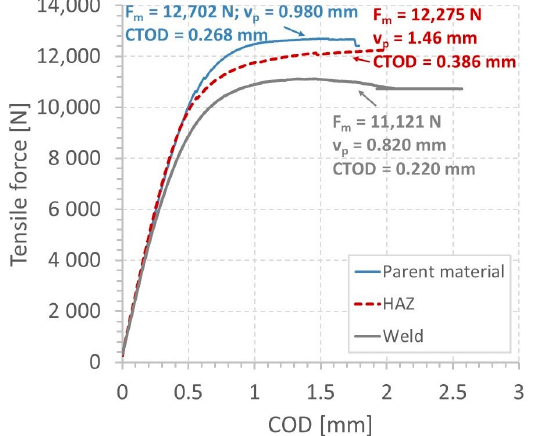
Figure 22. Force versus COD for: the parent material, HAZ and weld.